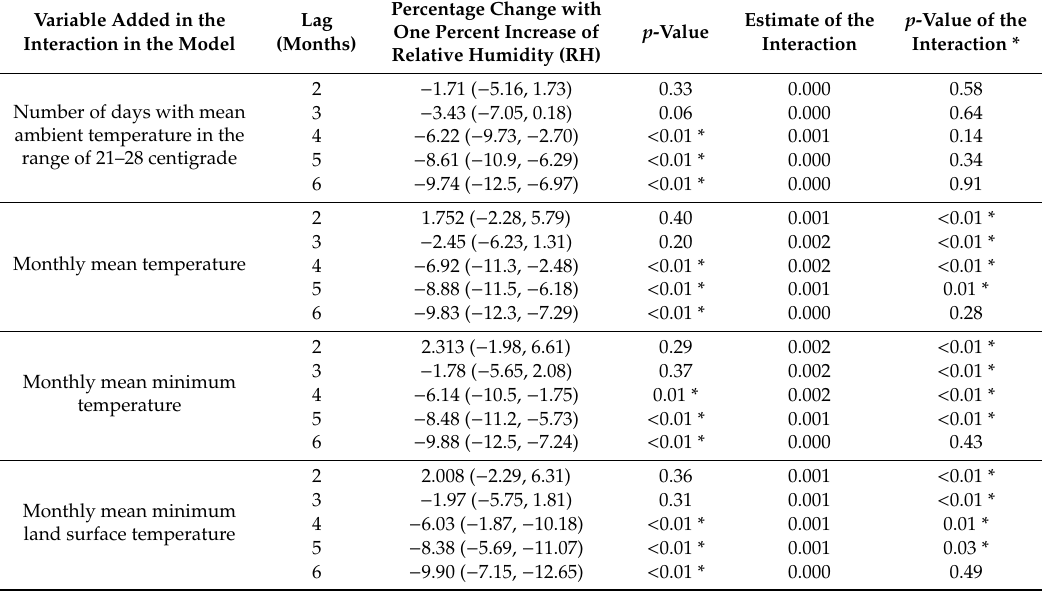
Table 4. Percent change of VL events associated per unit increase of relative humidity (RH) from multiple-variable